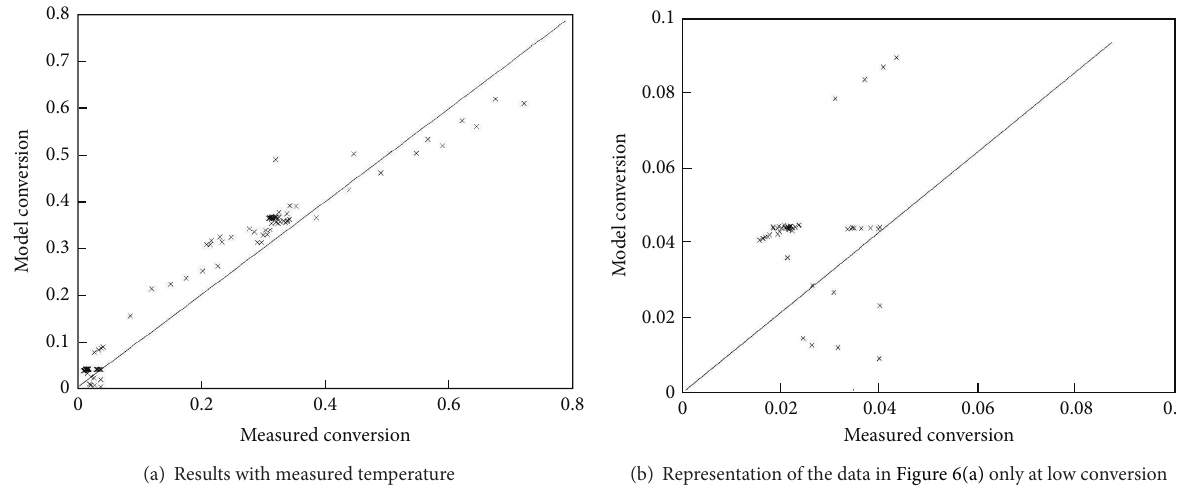
(b) Representation of the data in Figure 6(a) only at low conversion Figure 6: Comparison of measured conversion and the conversion predicted by the model using data from a plug-flow reactor.